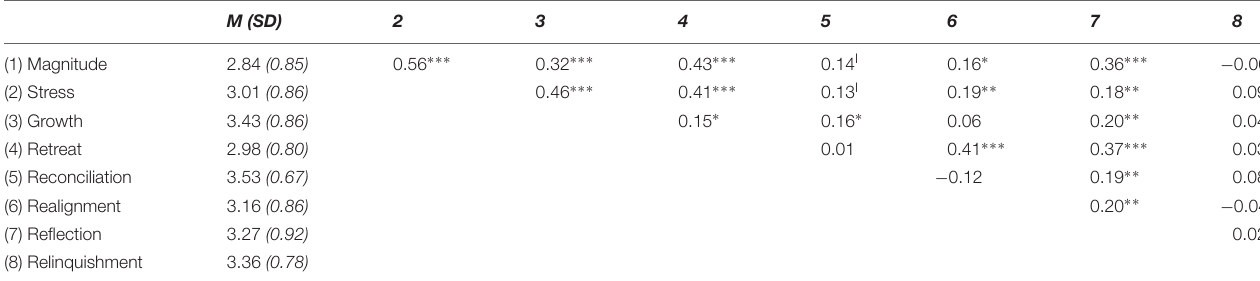
TABLE 2 | Means, standard deviations and correlations for the experience and management of identity conflict (Study 2). M (SD) 2